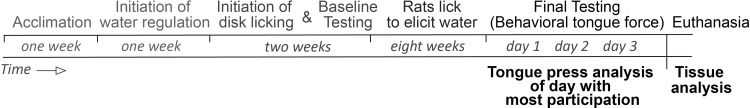
Depiction of behavioral training and testing periods for collection of tongue press force data and tongue press timing data.